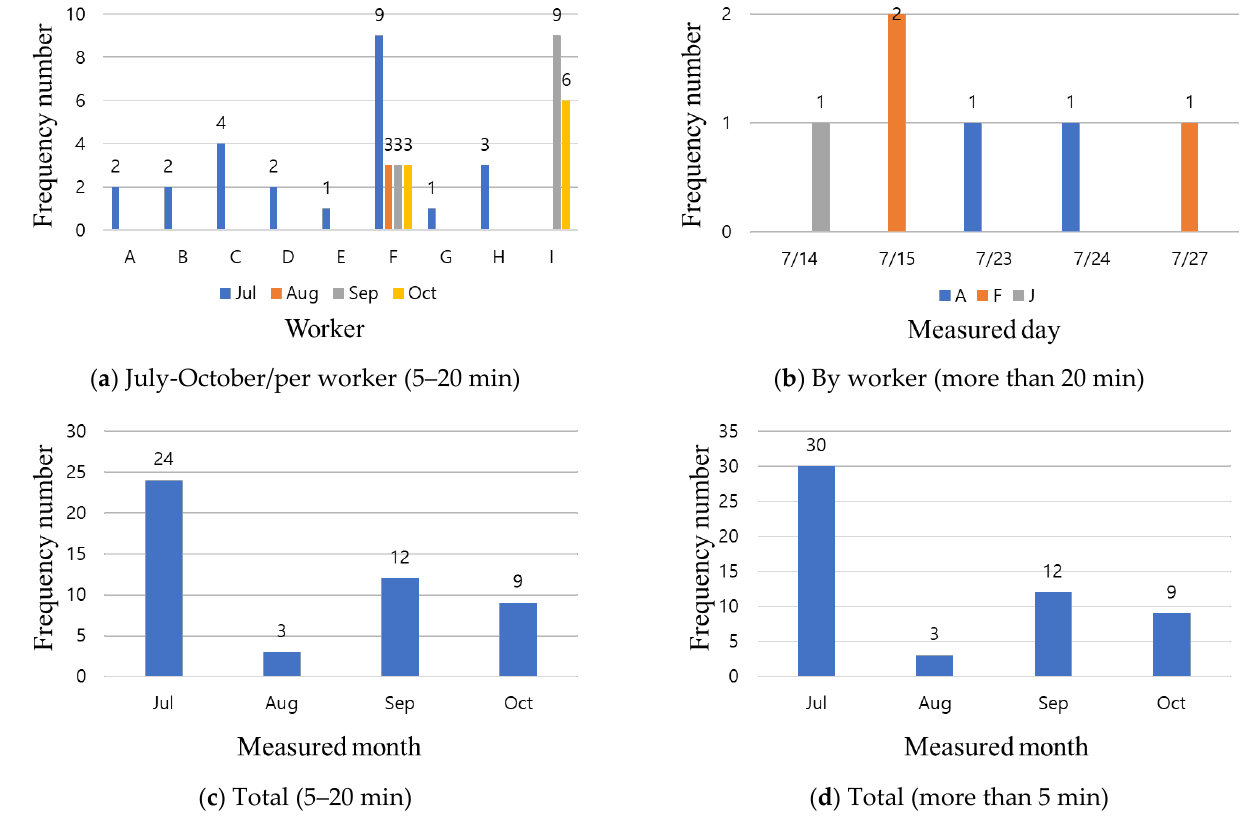
Figure 9. Analysis of fall risk area access (FRAA) sensor data for A site.